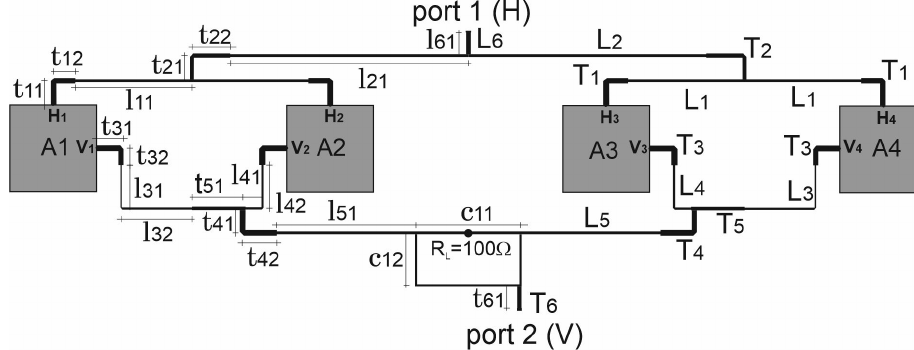
Figure 13. Layout of the array applied in full-wave analysis.